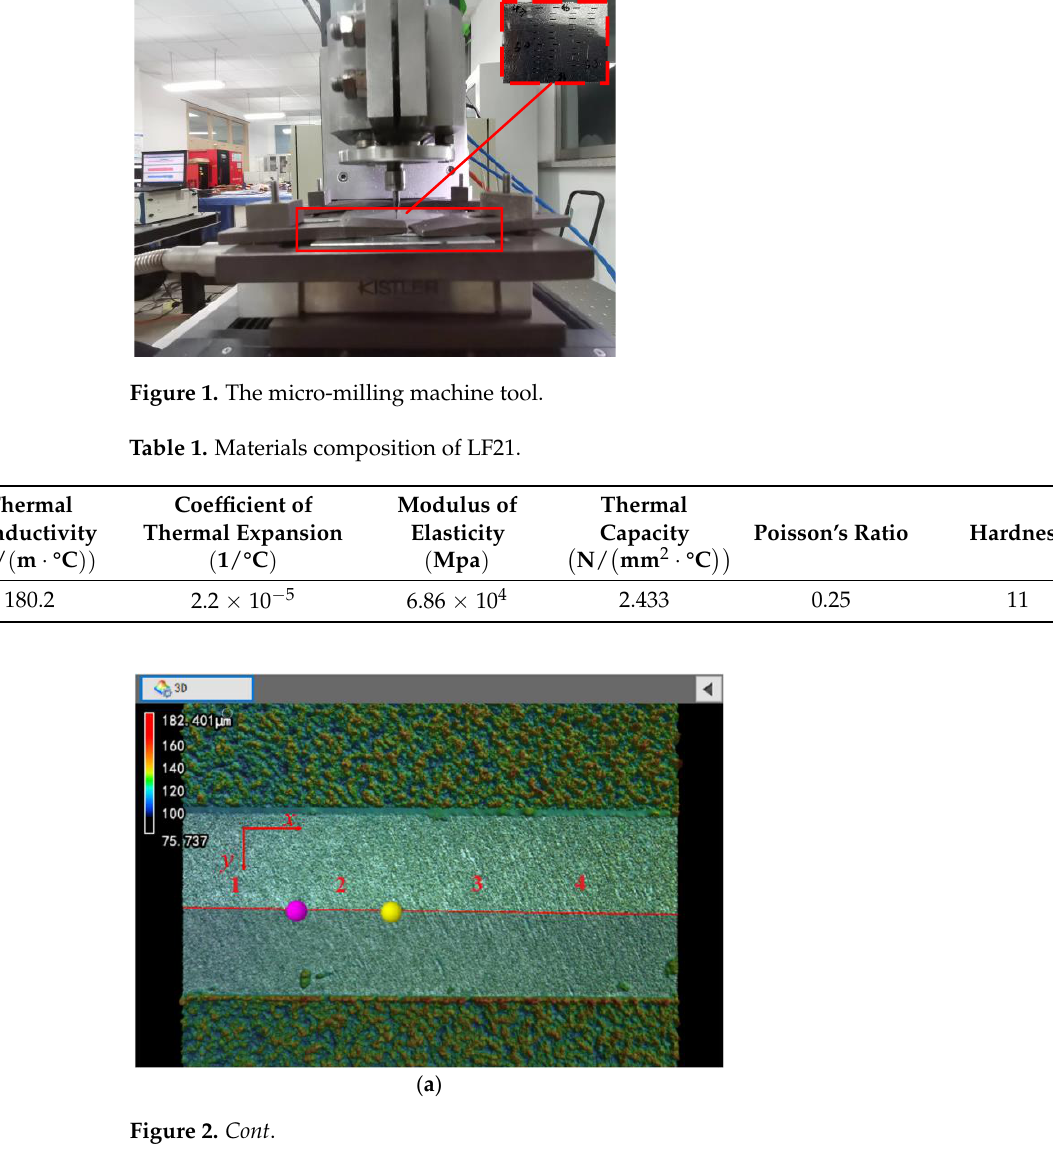
( b ) Figure 2. Surface roughness measurement at 65,000 rpm and 0.2 μm/z . ( a ) Three-dimensional to- pography of sidewall surface. ( b ) Two-dimensional surface. Where x and y represent the feed and the depth of cut directions. The averages of the surface roughness values, measured at 4 equidistant locations on each slot, were used for the analysis. 2.1.2. Process Setup The experiments were conducted using the Design of Experiment (DoE) methodol- ogy. We conducted an orthogonal trial with a mixed-level design utilising two factors: the spindle speed n and the radial depth of the cut ae. The above experiments were conducted to understand the effect of cutting parameters on surface roughness. Table 2 shows the selection of cutting parameters. Table 2. Process window.